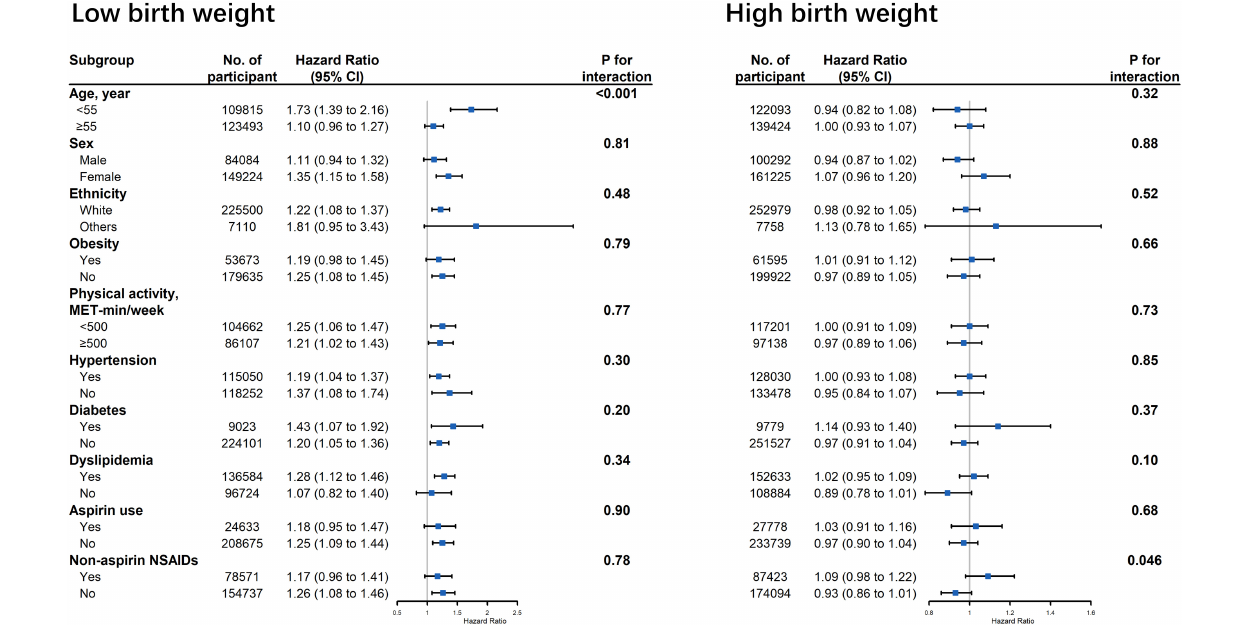
Frontiers in Cardiovascular Medicine |